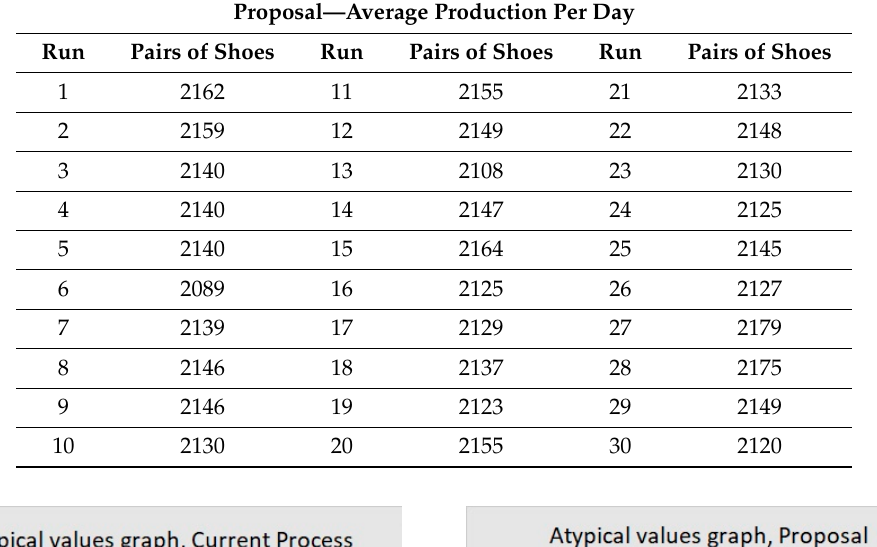
Table 10. Average production / day of the proposed process.